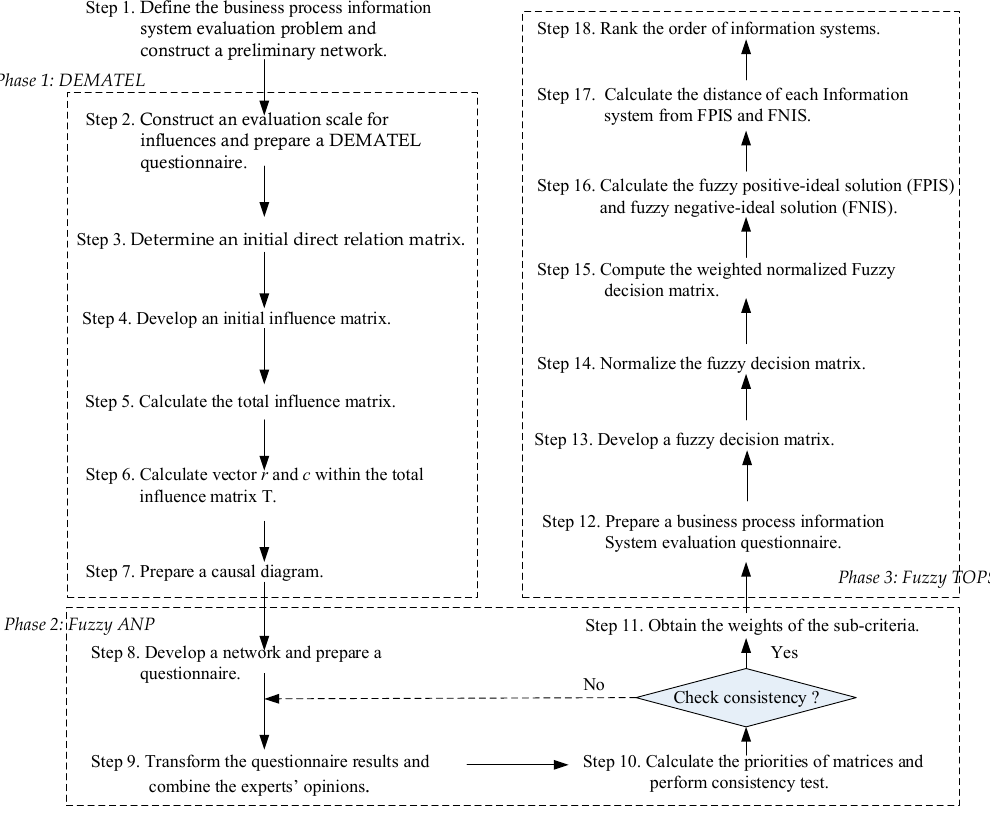
Figure 1. Business process information system evaluation model.